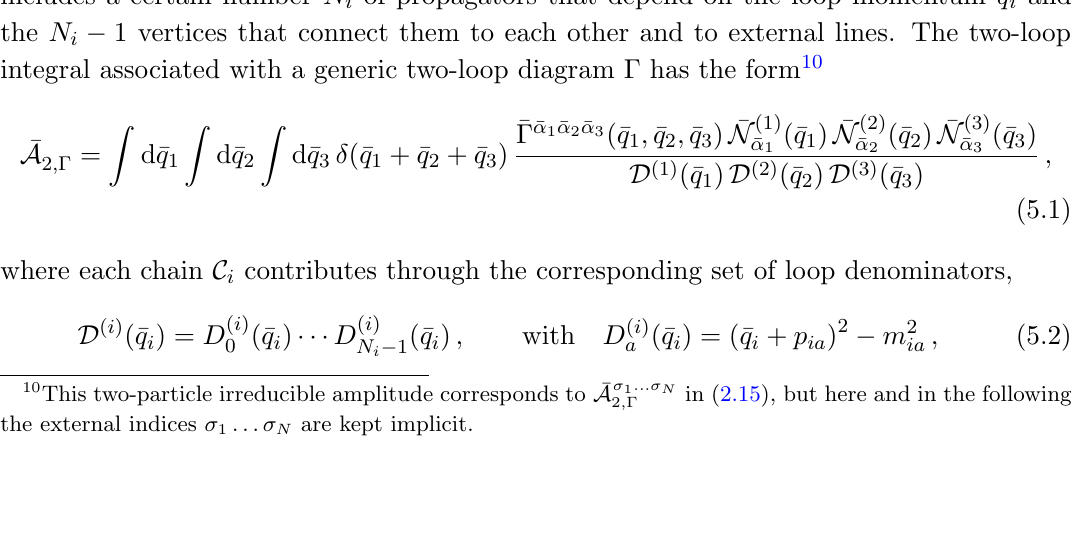
n = D ( " ) are implicitly O